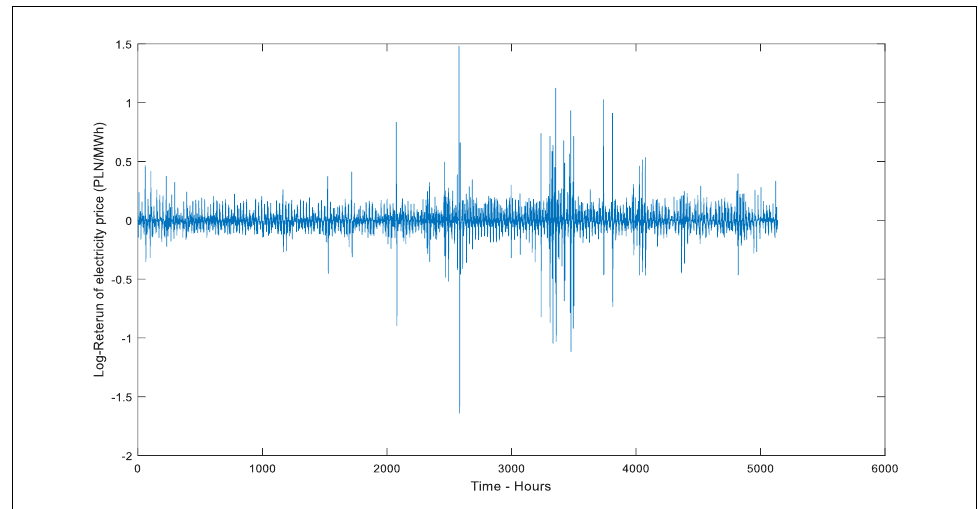
Figure 2. Hourly log-return of spot price for Polish electricity market.